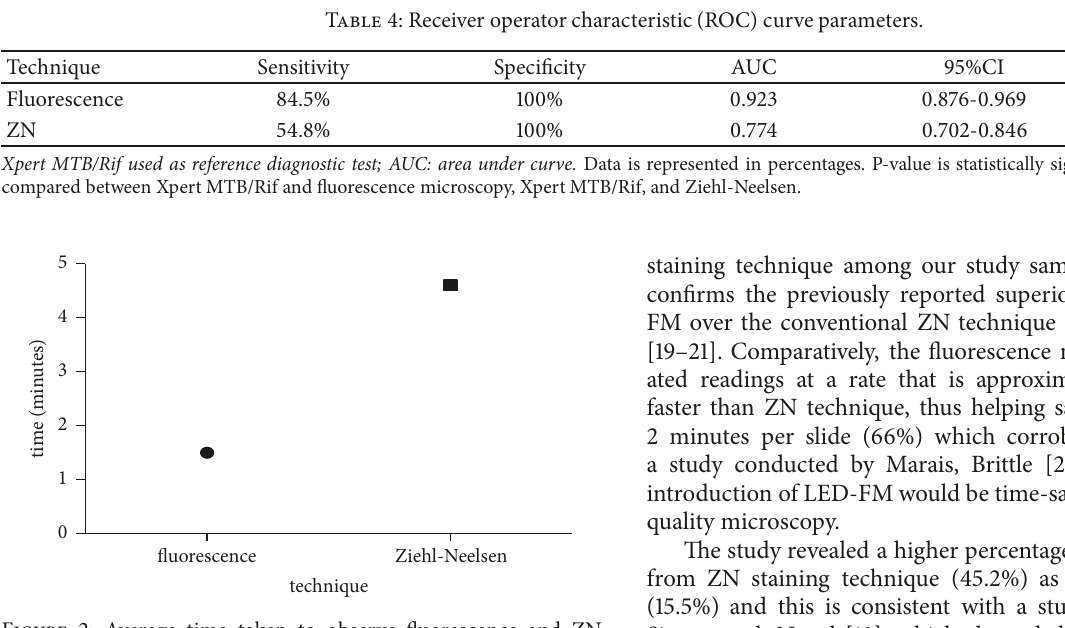
Figure 2: Average time taken to observe fluorescence and ZN stained